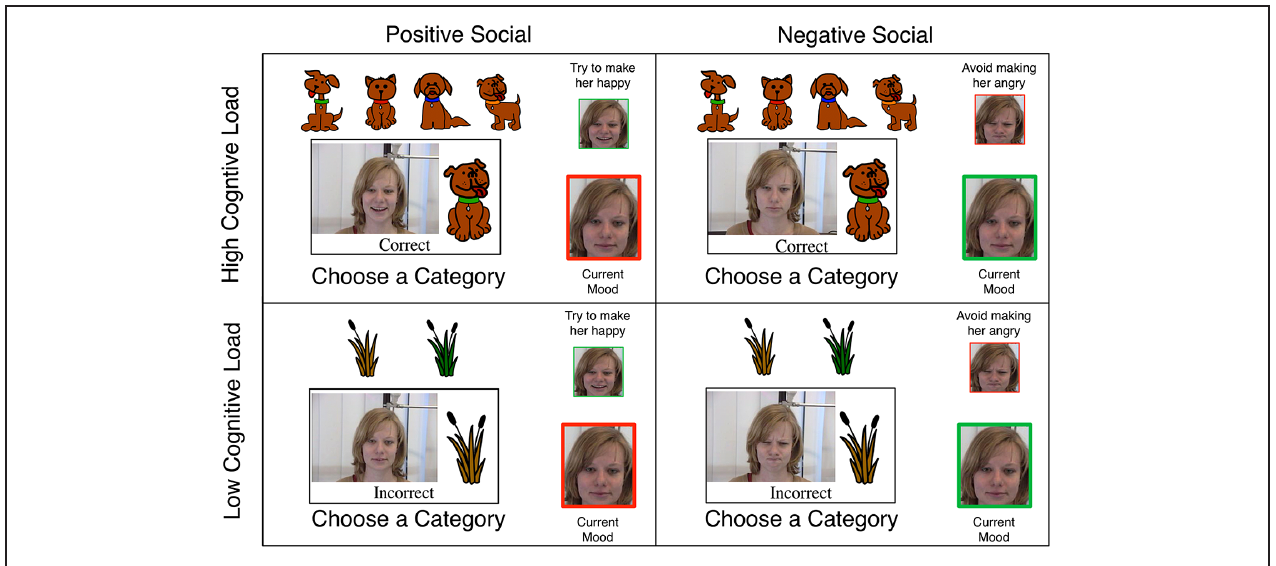
FIGURE 1 | An adapted schematic of the task from Gorlick et al. (2013). This task directly manipulated task demands on cognitive control. Behavior suggests that learning with social feedback depends on a complex three-way interaction between task demands (high cognitive control demand (top) : three